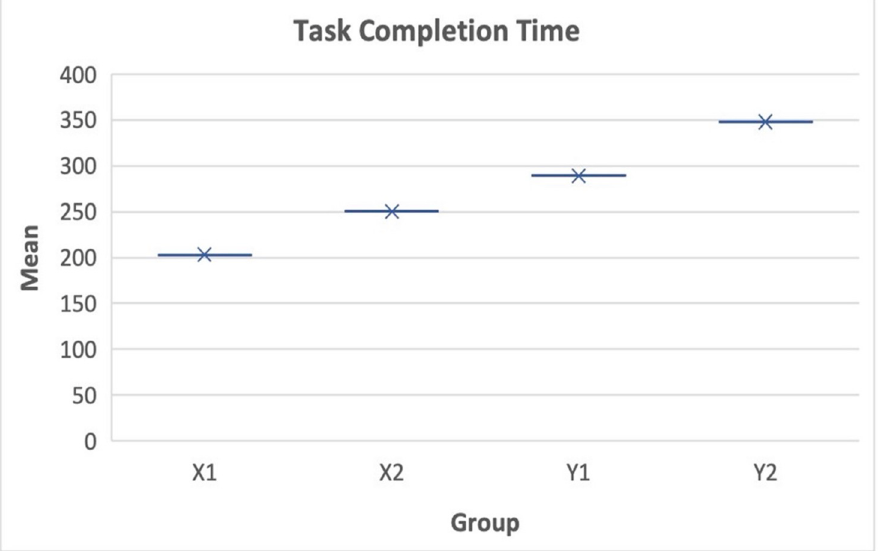
Fig 4. Mean task completion time. Mean sufficient and mean